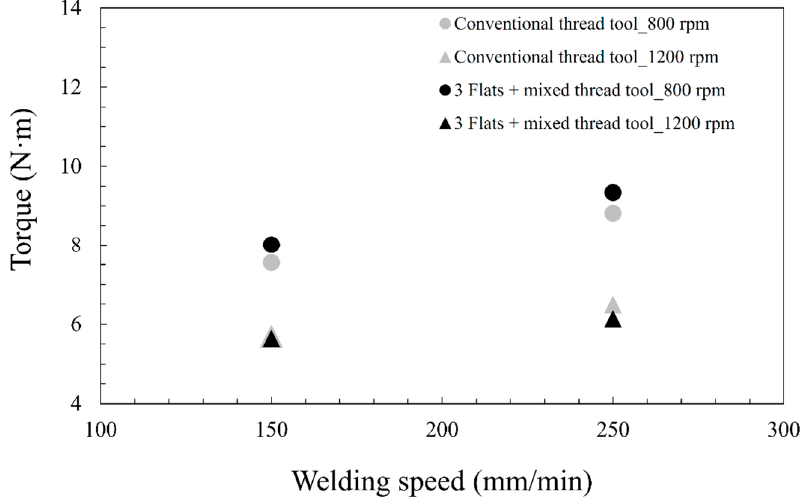
Figure 10. Torque as a function of welding speed for the studied tool geometries and rotational speeds.